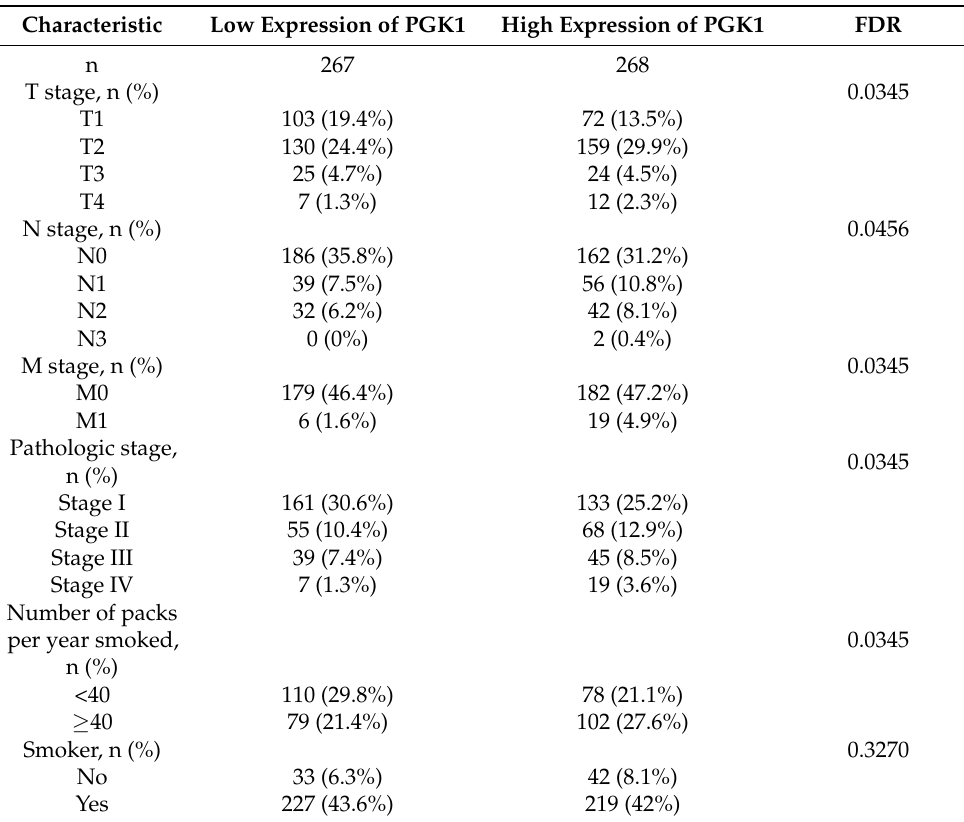
Table 1. The relationship between PGK1 expression and clinicopathological characteristics in TCGA LUAD